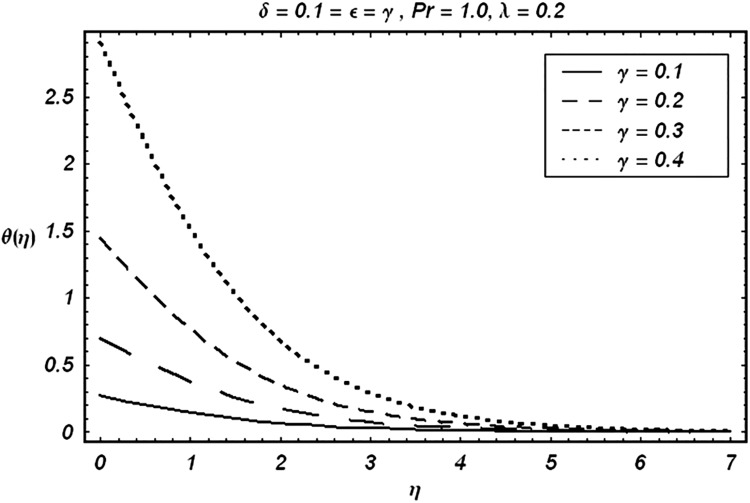
Variation of γ on θ.